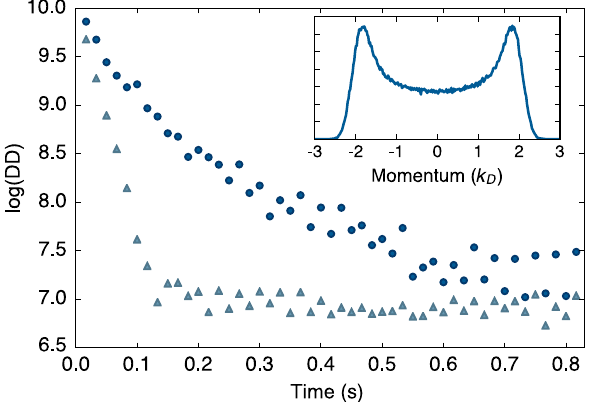
FIG. 12. Time evolution of distance to dephasing (DD) pre- dicted by the collisionless classical dynamics simulation for two cases: the first for when only process (ii) is present (circle), and second when both (i) and (ii) are present (triangle). The inset shows the dephased momentum